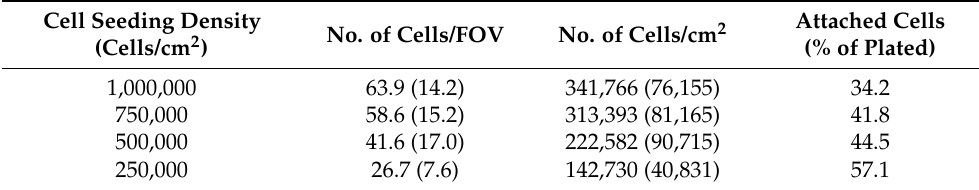
Table 3. Number of cells on filters on day 2 or day 3 (250,000 cells/cm 2 ). Values are presented as mean (SD) of at least four independent iBMEC differentiations. A minimum of 10 images (usually >30 images) per differentiation were used for calculating the number (no.) of attached cells. Cell Seeding